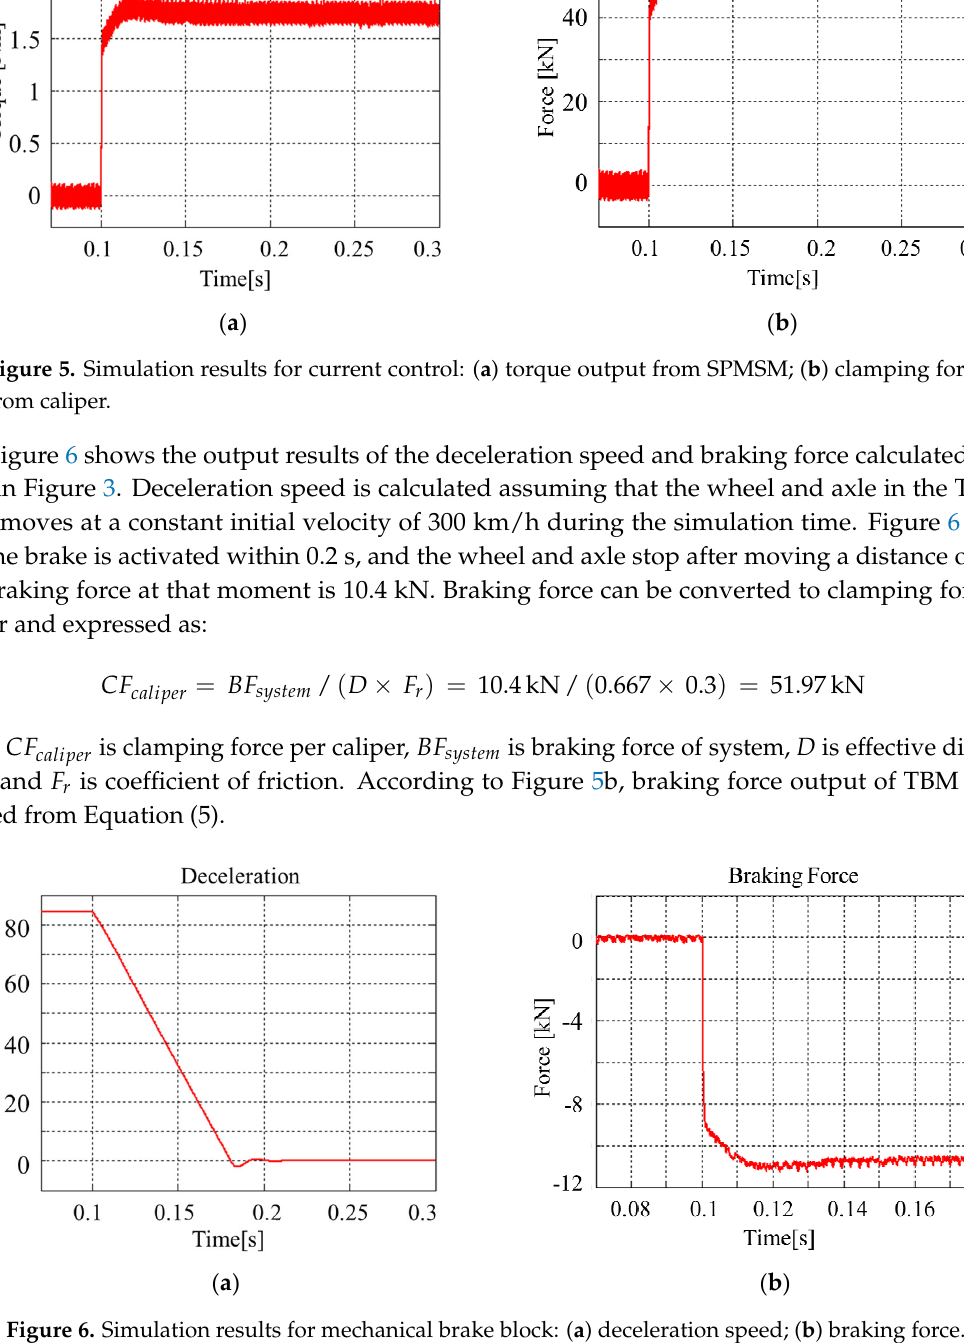
Figure 6. Simulation results for mechanical brake block: ( a ) deceleration speed; ( b ) braking force.